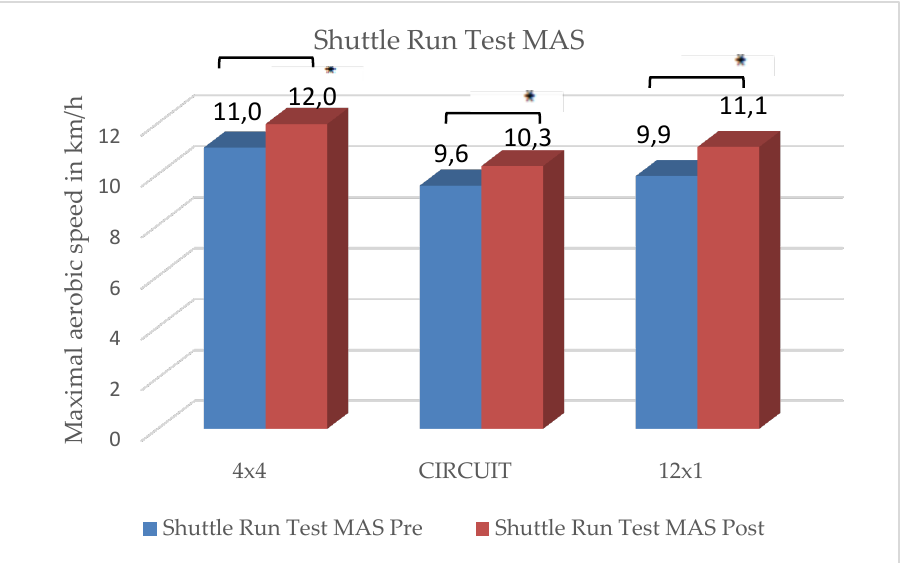
Figure 2. Changes in aerobic endurance capacity within intervention groups . * Significant difference between pre- and posttest ( p < 0.05).